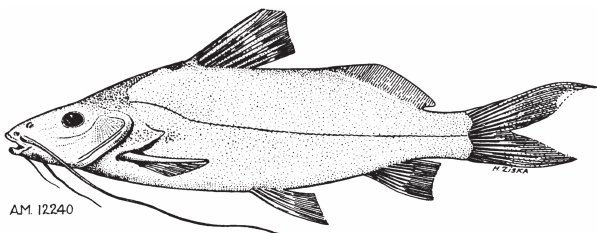
Fig. 1. Pimelodus brevis Marini, Nichols & La Monte, 1933, holotype, AMNH 12240, 285.0 mm SL. Modified from Marini et al . (1933).